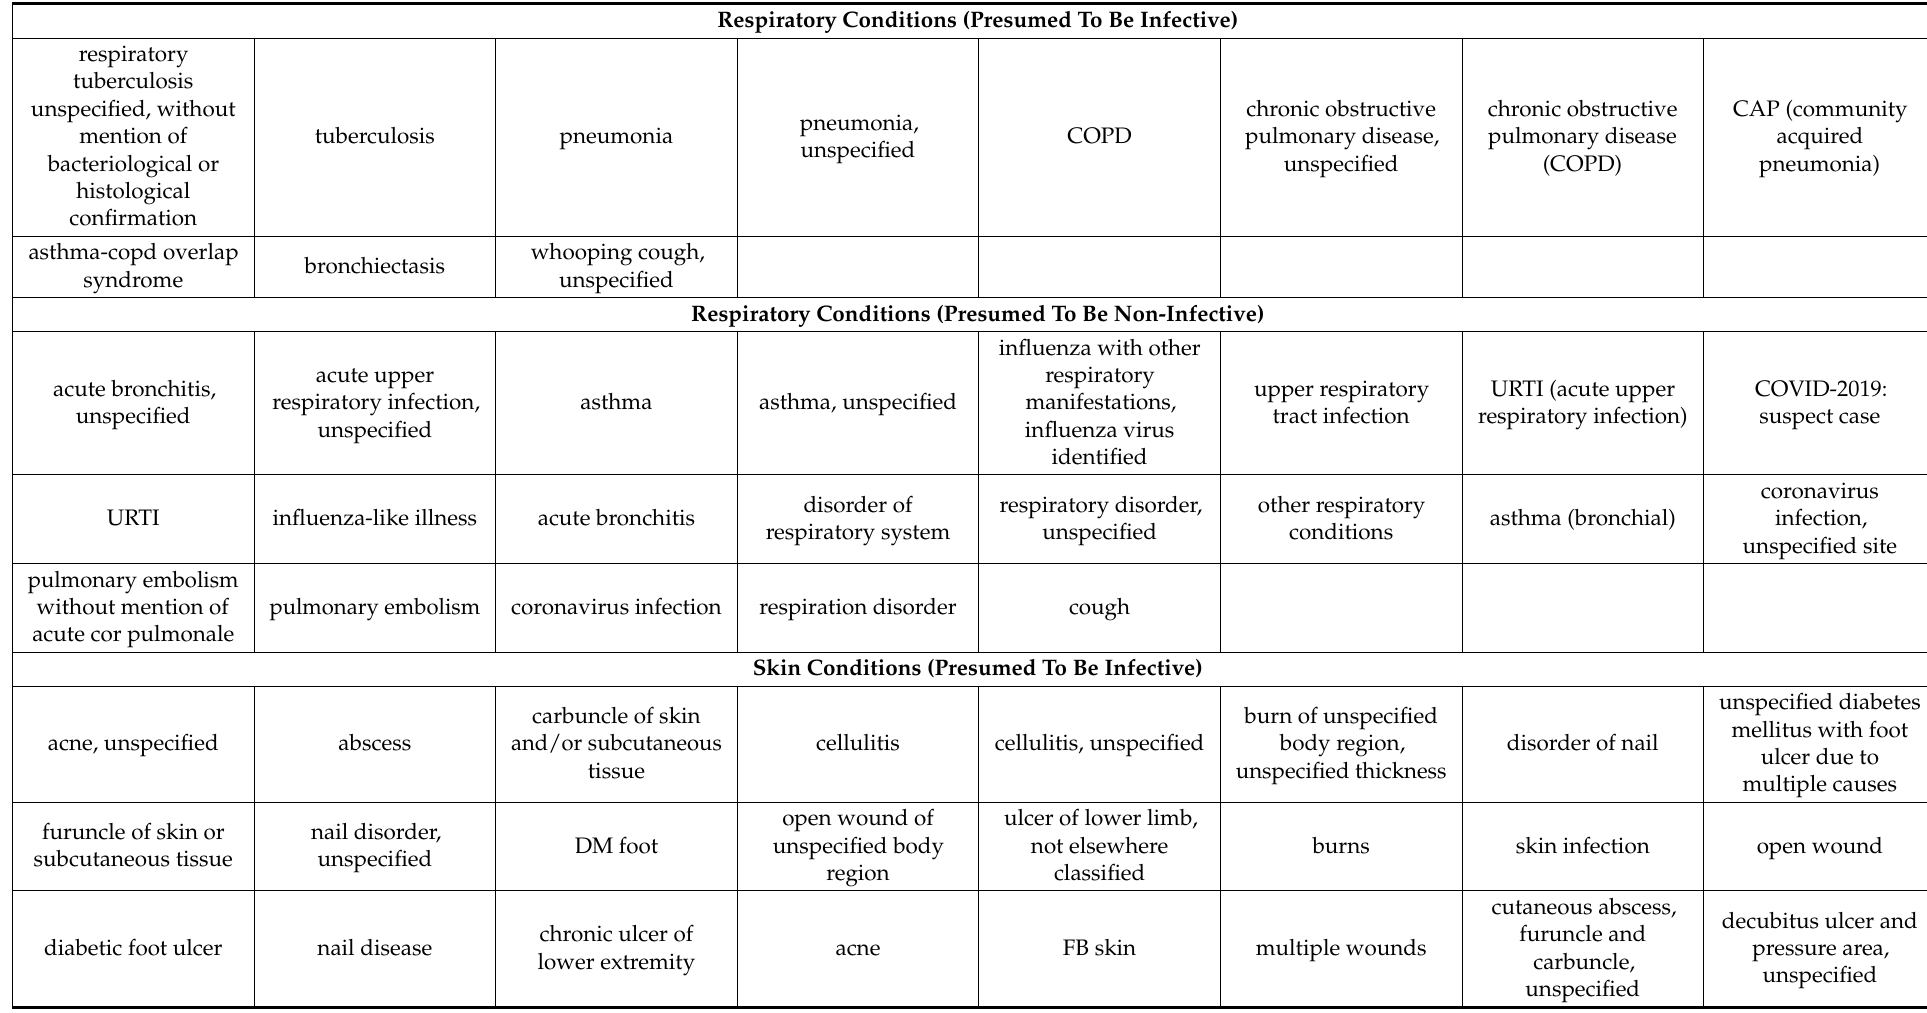
Table A1. List of diagnosis codes and